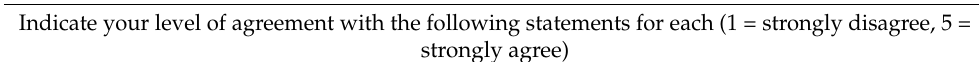
Table A1. Items and sources of the variables used in the research.